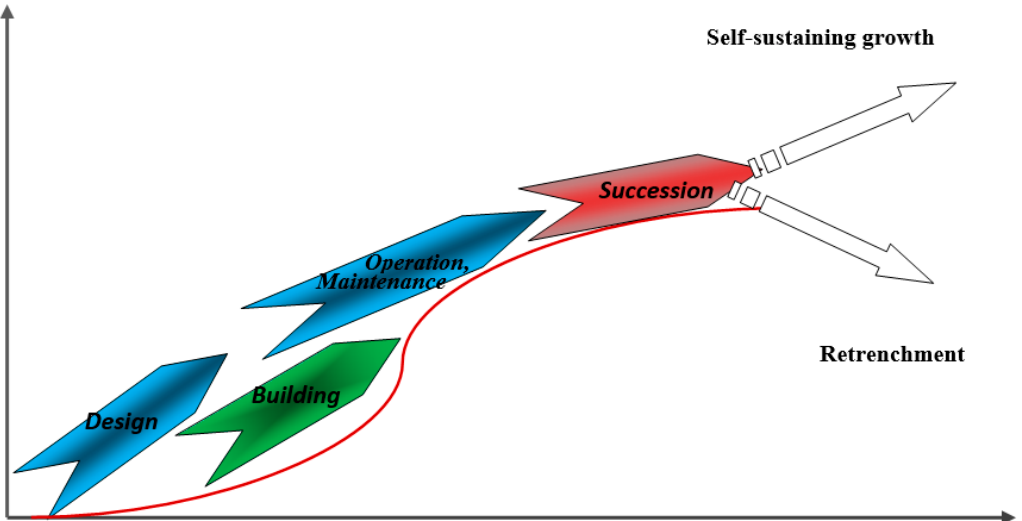
Figure 2. Life cycle of an industrial ecosystem implementing an innovative projects portfolio [29]. (1). Conceptual Design